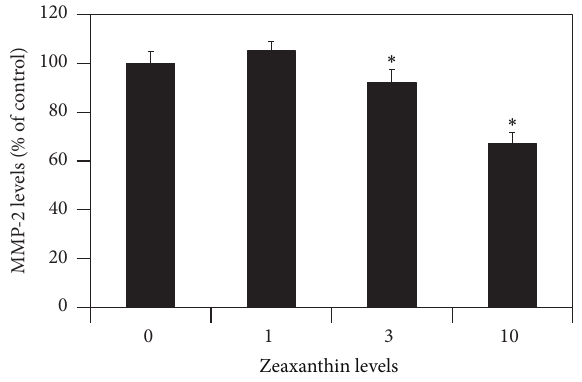
Figure 5: Zeaxanthin inhibits secretion of MMP-2 protein by cultured UM cells. UM cells were seeded into 12-well plates and were cultured with or without zeaxanthin (10 𝜇 M). After being cultured for 24 h, conditioned medium was collected and centrifuged and the supernatants were collected. The amount of MMP-2 in the supernatants was determined using the Human MMP-2 ELISA kit. Zeaxanthin at 3 𝜇 M and 10 𝜇 M significantly inhibited the secretion ofMMP-2( 𝑛 = 3 , 𝑃 < 0.05 ). ∗ 𝑃 < 0.05 ,versuscontrol(cellscultured without